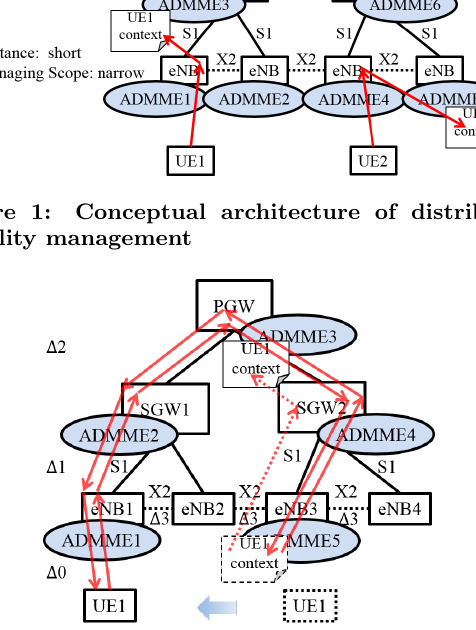
Figure 2: Example of UE movement and ADMME